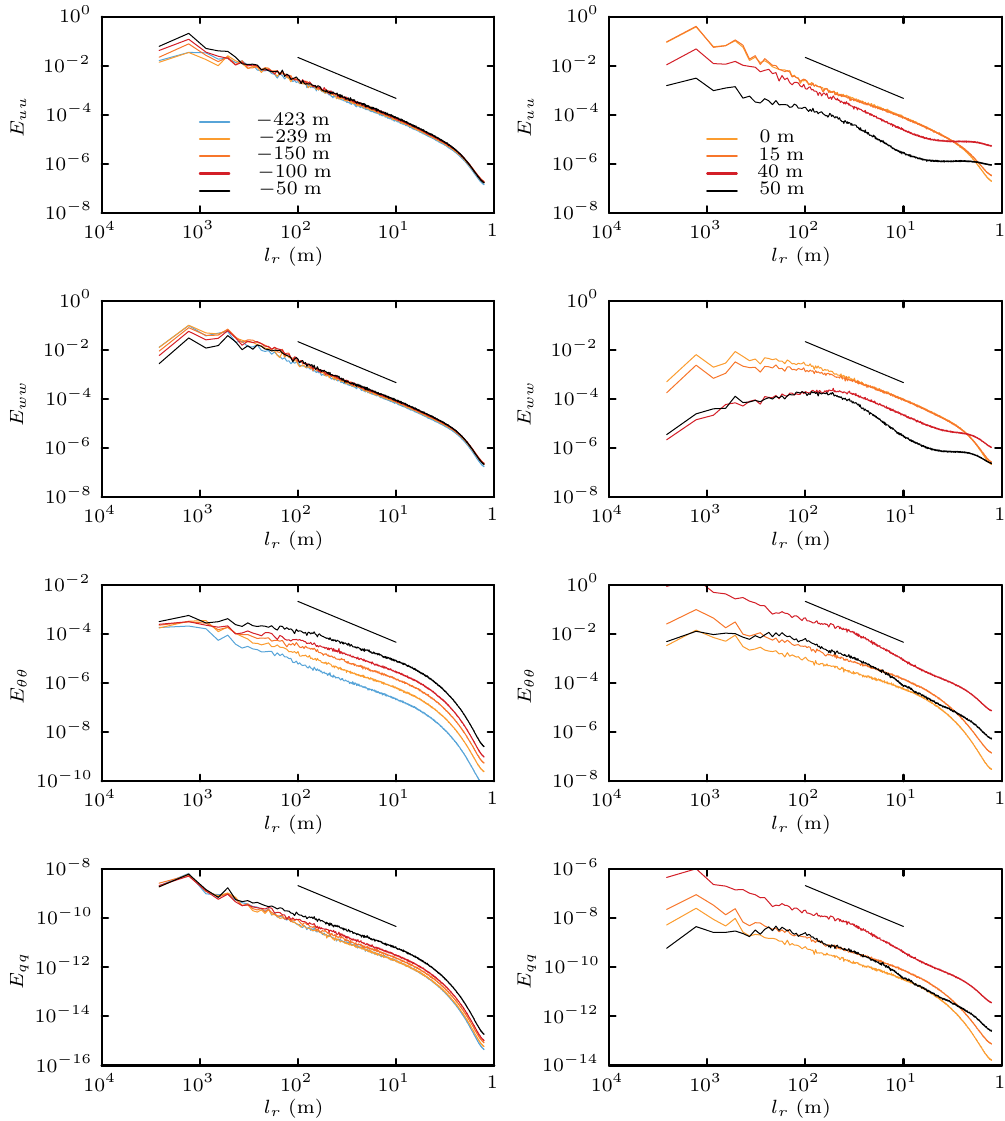
Figure 10. Radial spectra of (top to bottom rows) zonal wind, vertical velocity, liquid water potential temperature, and total water mixing ratio. The legend denotes heights with respect to the height of the maximum mean cloud liquid z ref . Left column panels correspond to spectra for z < z ref and right column to z > z ref . For reference, on the left panels the spectra at the middle of the boundary layer (below cloud base) at z − z ref = − 423 m are shown. The black straight line denotes ∼ k − 5/3 scaling. The x -axis labels are converted to length scale to aid the physical interpretation of the